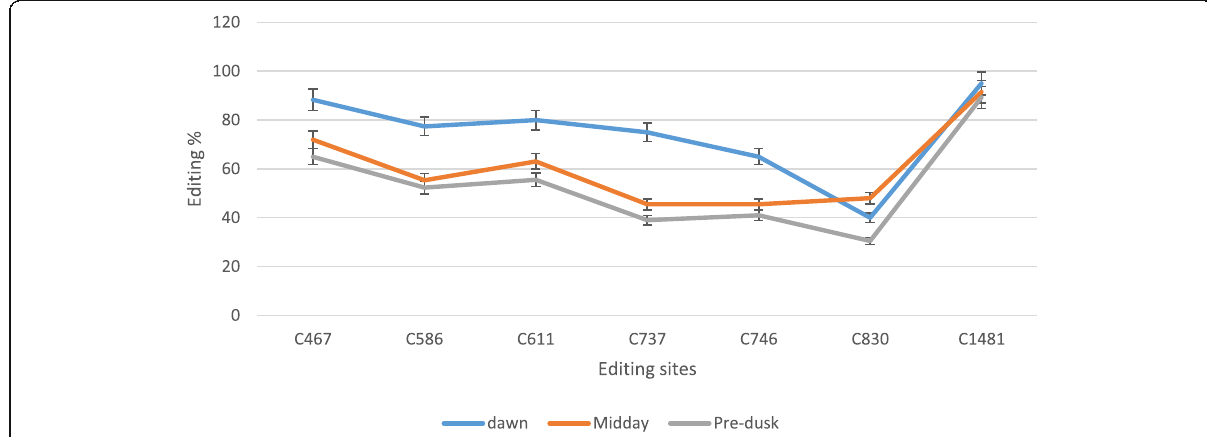
Fig. 4 QRT-PCR confirmation of Calotropis procera ndhB editing sites predicted by CLC genomic workbench in different 3 times (dawn, midday, and pre-dusk). Data are expressed as means with ± SD (black bars) of three biological